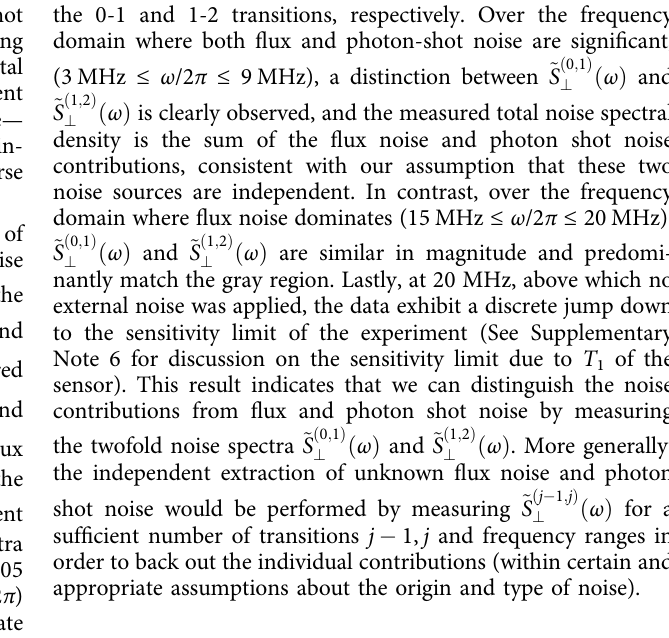
Fig. 4 Distinguishing the noise contributions from fl ux and photon shot noise. a Transverse fl ux noise PSDs ~ S by performing SL (0,1) , SL (1,2) for engineered Lorenztian fl ux noise (gray fi lled) centered at 6 MHz. b Transverse photon shot noise PSDs ~ S ~ S ð 1 ; 2 Þ ð ω Þ (red) for engineered photon shot noise with detuning Δ /2 π = 6.05 MHz from the readout resonator. c Total transverse noise PSDs ~ S ð 0 ; 1 Þ (cid:2) n ; ? ð 1 ; 2 Þ ð ω Þ (red) for a mixture of engineered fl ux noise (gray-shaded box-car, 1 MHz to 20 MHz), and coherent photon shot noise with detuning Δ /2 π = and ~ S ? 6.05 MHz (blue- and red-shaded Lorentzians). Measuring the twofold noise spectra ~ S contributions. Error bars represent ±1 standard